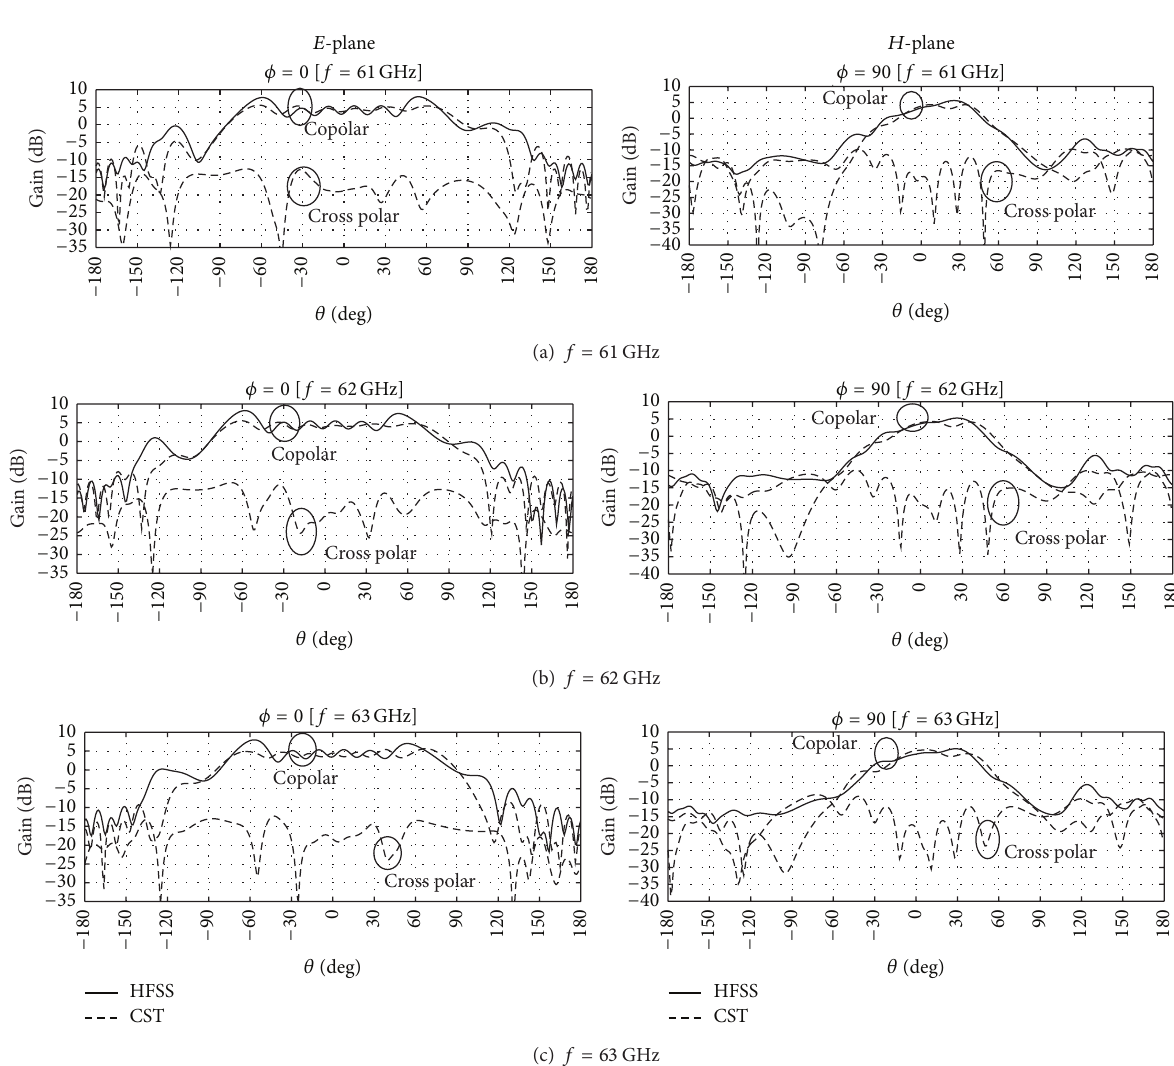
Figure 6: 𝐸 -plane and 𝐻 -plane radiation patterns for SIW single antenna element at three